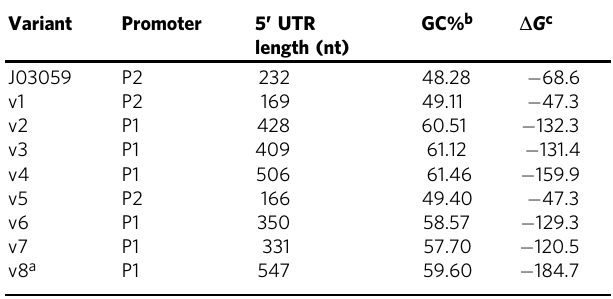
Table 1 Sequence properties of the 5 ’ UTRs of GBA